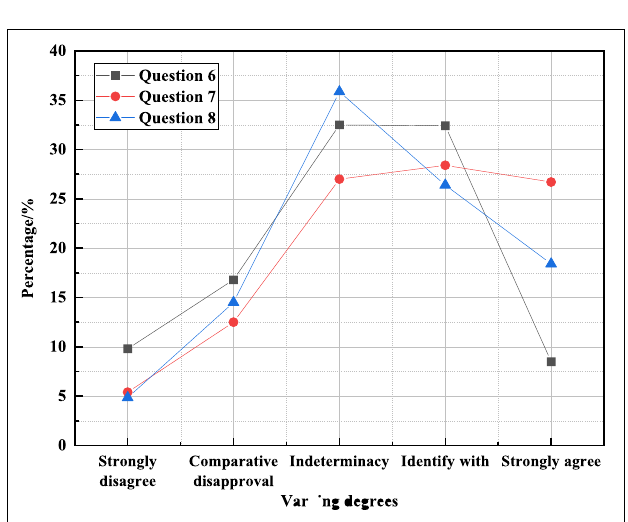
FIGURE 7 | Basic situations of college students’ attention to Internet celebrity.